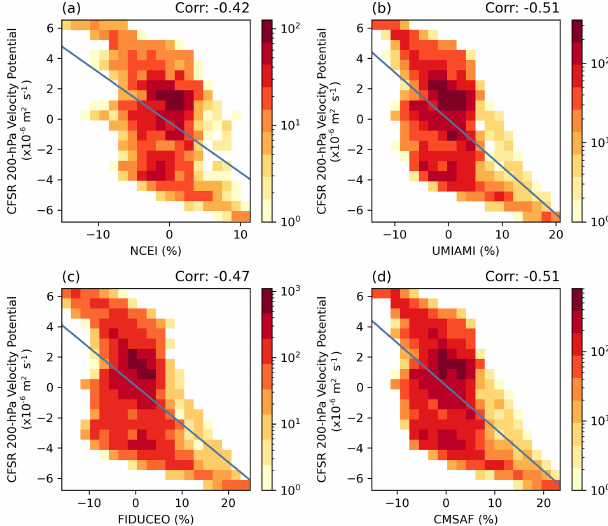
Figure 9. Similar to Fig. 7 except for UTH anomalies vs. anomalies of CFSR 200hPa velocity